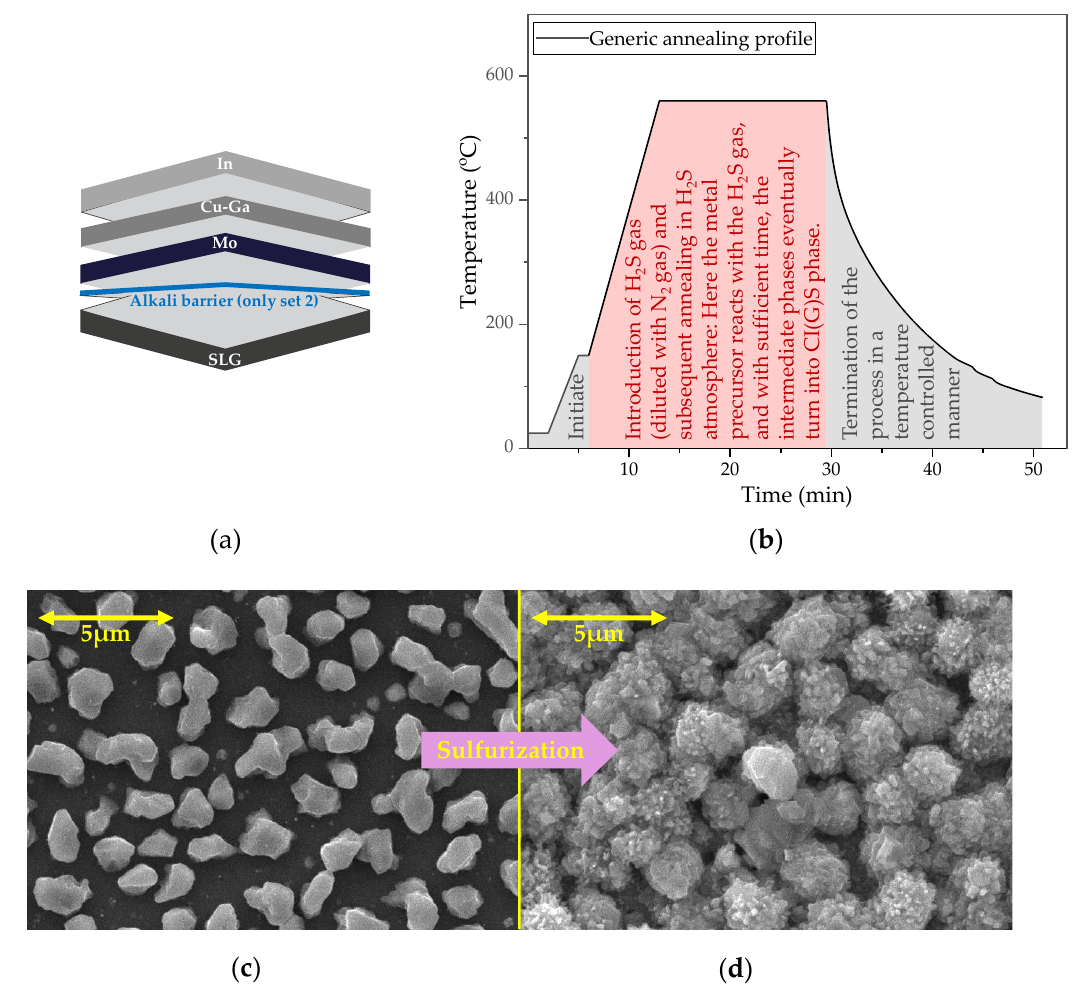
Figure 1. Precursor stack ( a ), its top view ( c ), generic annealing profile ( b ) and CIGS layer top view ( d ). Table 1. Processing parameters and respective levels. Codes Processing